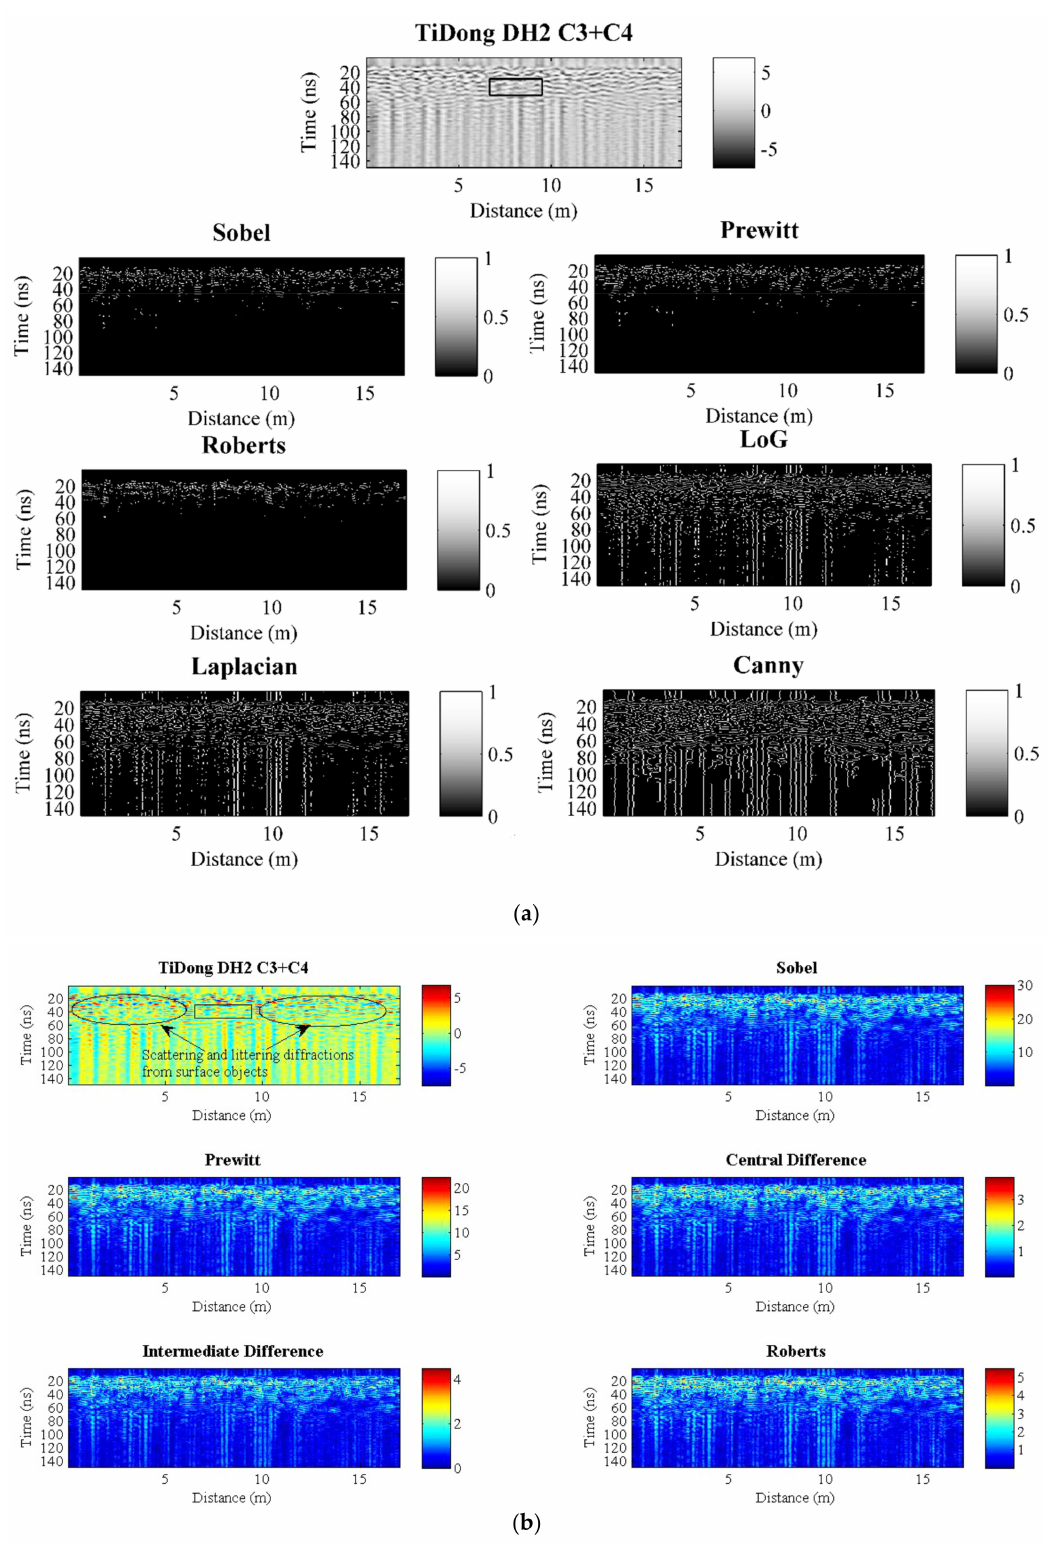
Figure 11. Results of MDEEMD edge detecting. The data were reconstructed by using the MDEEMD technique before edge detecting. The inferred response of the buried hot spring well is within the marked rectangular box shown in the MDEEMD reconstructed profile. ( a ) Binary edge maps. ( b ) Two-dimensional edge